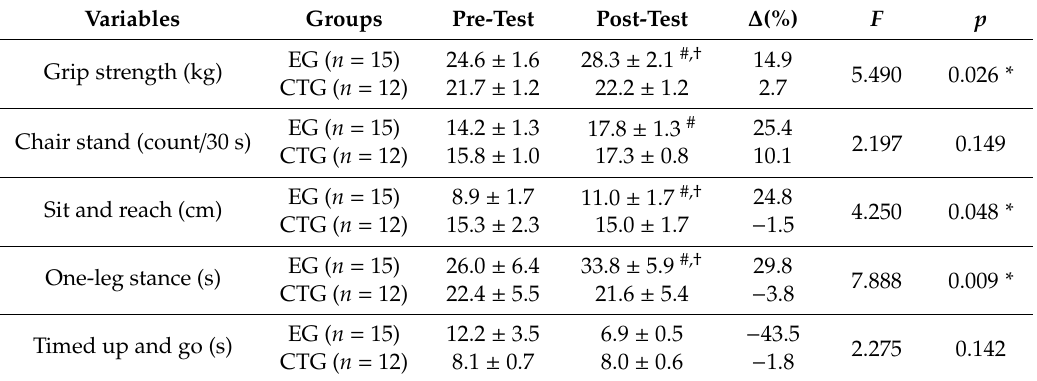
Table 3. Changes of functional fitness between exercise and control group in EBE